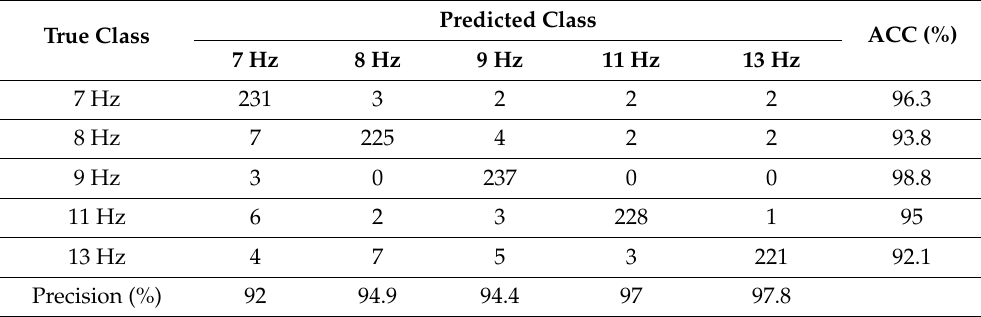
Table 11. The confusion matrix for the SSVEP recognition results using MSI classifier for the room information test in the second experiment (Scenario